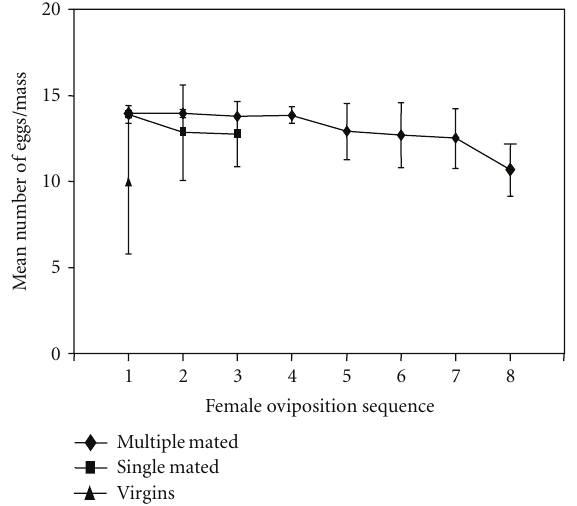
Figure 1: Mean number of eggs oviposited by Edessa meditabunda females in successive ovipositions. Multiple-mated females: females maintained with males during all their reproductive life. Single- mated females: females maintained with males until complete one mating. Virgins: females maintained isolated of males during all their reproductive life. Vertical lines indicate the standard deviation of the means.